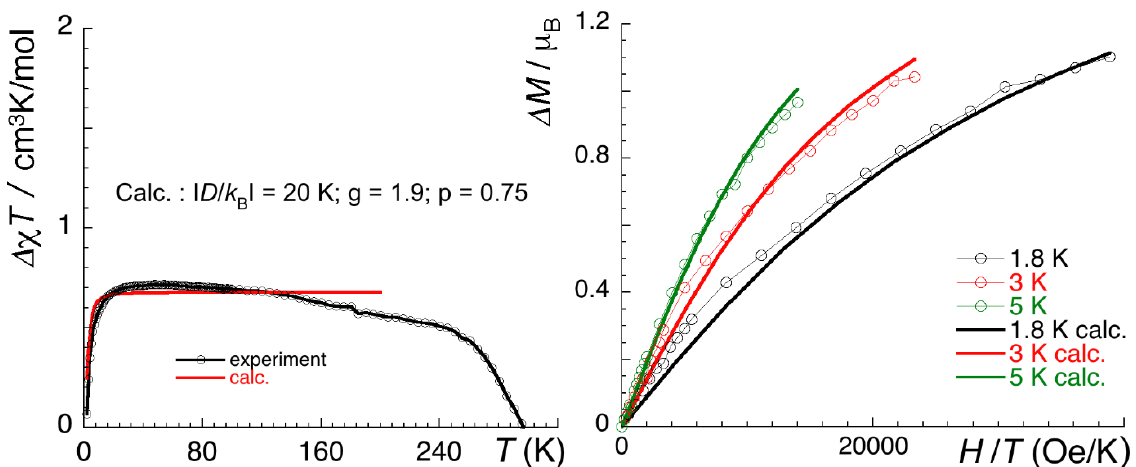
Figure 6. ( Left ) χ T = f( T ) plot of 1 obtained with the difference of χ T before and after irradiation (open dark points). In red, theoretical model for the triplet state (see text). ( Right ) M = f( H/T ) of the reduced magnetizations obtained with the difference of M before and after irradiation (open points) at different temperatures. In colored lines, theoretical models for the triplet state (see text).